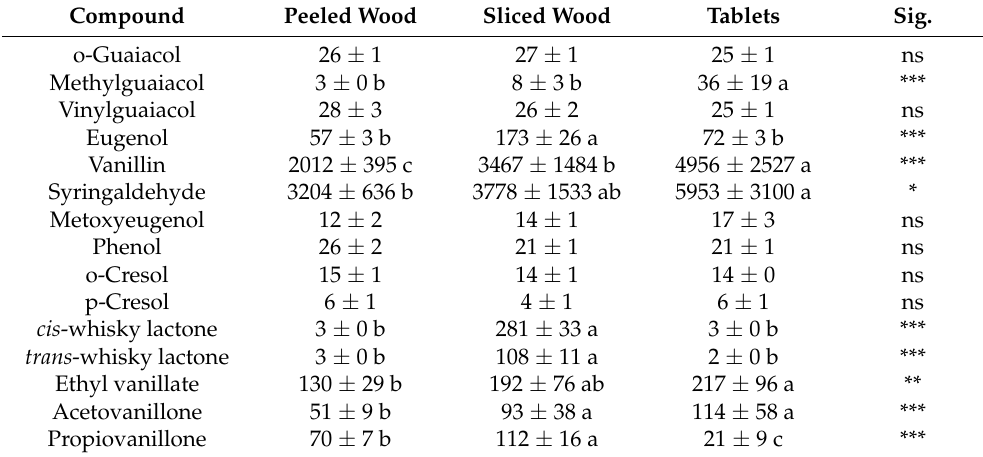
Table 7. The values represent the means measured for each wood format ± standard error (SE). All data are expressed in µ g/L except where expressly indicated. Different letters within each row denote significant difference between the wines at p < 0.05 (Tukey’s post hoc test). *, **, *** and ns: differences significant at p < 0.05, 0.01, 0.001 and not significant, respectively. The results refer only to the test samples treated with oak wood.